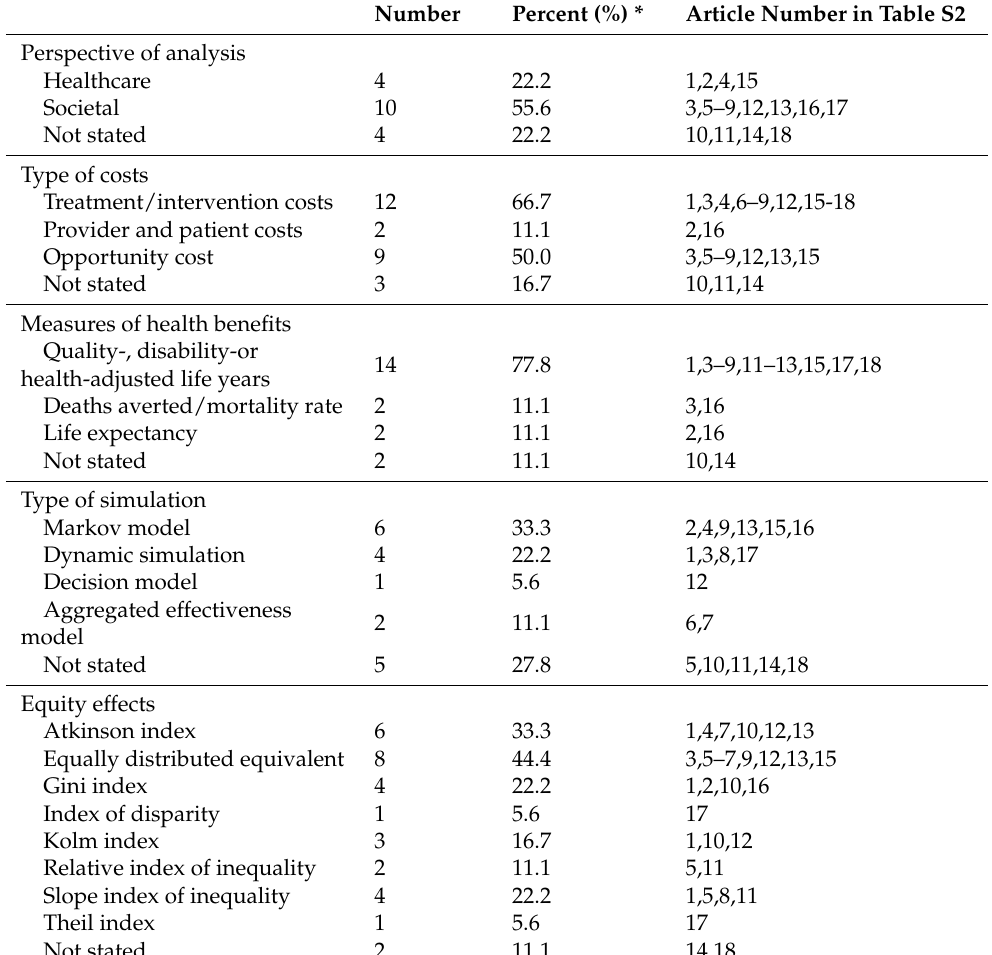
Table 2. Design characteristics of the included studies (N =